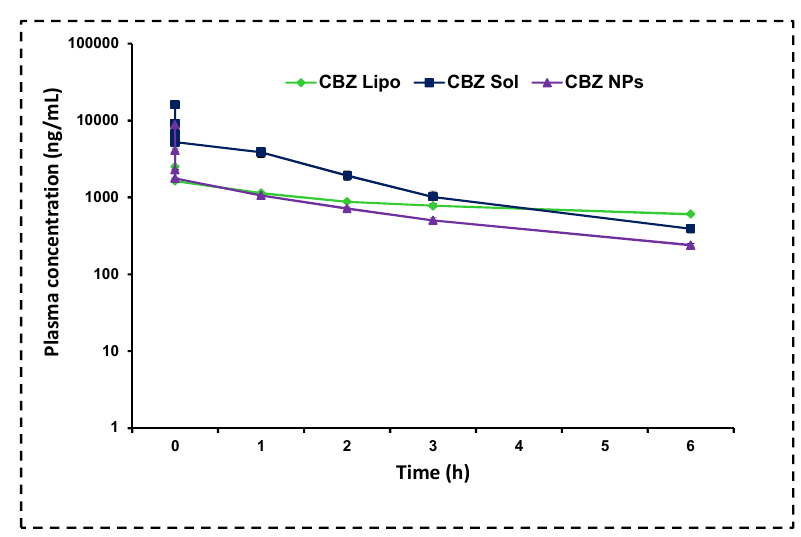
Figure 10. Pharmacokinetics: Mean plasma concentration and time profiles of micellar CBZ solution, CBZ liposomes, and CBZ NPs in rats after i.v. administration (dose 15 mg/kg). The results clearly showed that the micellar CBZ solution has shown more AUC tot and C max because of the presence of tween 80 and ethanol, which is lethal to cause neutropenia. In contrast, the groups administered CBZ NPs and CBZ liposomes have shown a 0.413-fold, 3.15-fold increase in half-life and 0.339-fold and 3.785-fold increase in MRT respectively. The data was represented in mean ± SD.